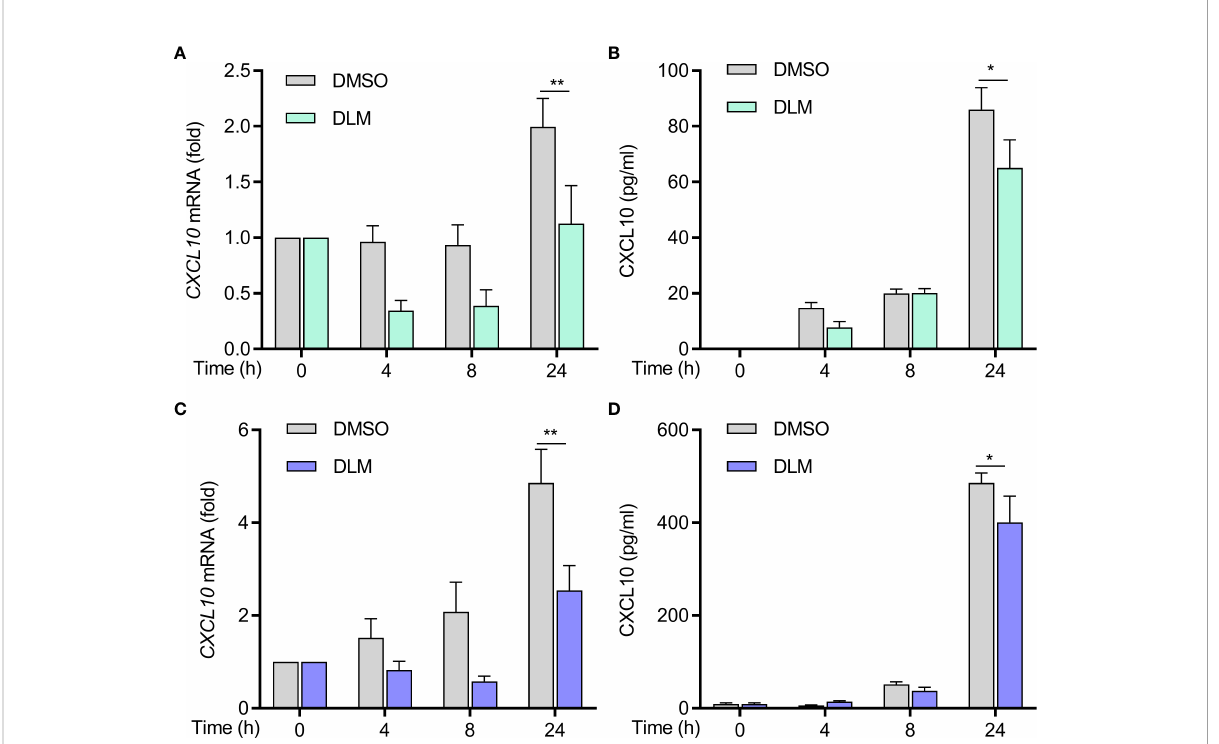
FIGURE 3 Decreased production of CXCL10 from DLM treated naive and DLMr-MTB infected macrophages. Macrophages were treated with DLM (0.3 m g/ mL) for 0-24 h, DMSO was set as control group. (A) Quantitative PCR analysis of CXCL10 mRNA and (B) ELISA of CXCL10 in supernatants of cells from each group. Macrophages were infected with DLMr-MTB and then incubated for an additional 0-24 h with DLM (0.3 m g/mL). DLM treatment led to a decrease in CXCL10 in infected macrophages (C, D) . Data are presented as mean ± SEM. * p <.05, ** p <.01 (two-way ANOVA). Results are representatives from at least three independent